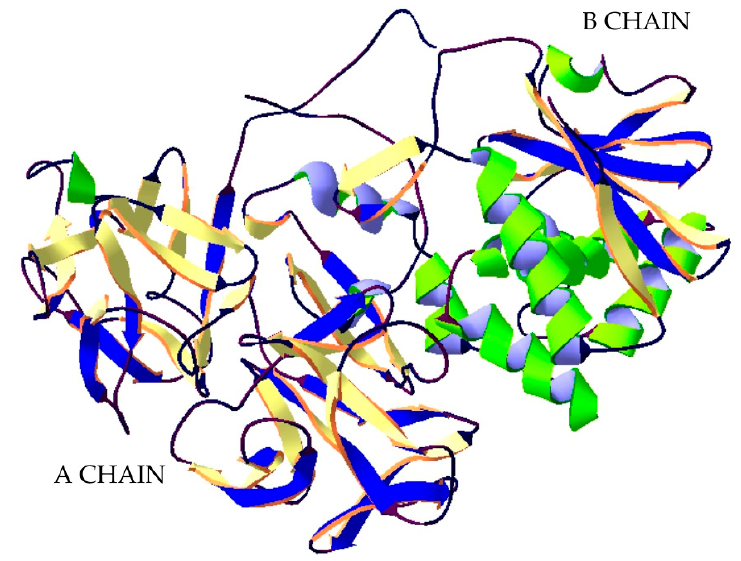
Figure 5. Structure of abrin. The crystal structure of protein (PDB: 1ABR) [91] was taken from the RCSB PDB databank (http://www.rcsb.org/) (access on 05.03.2018). Visualization of the three-dimensional structure of the protein was performed using the Swiss-PdbViewer (http://spdbv.vital-it.ch/) (access on 05.03.2018) [29].